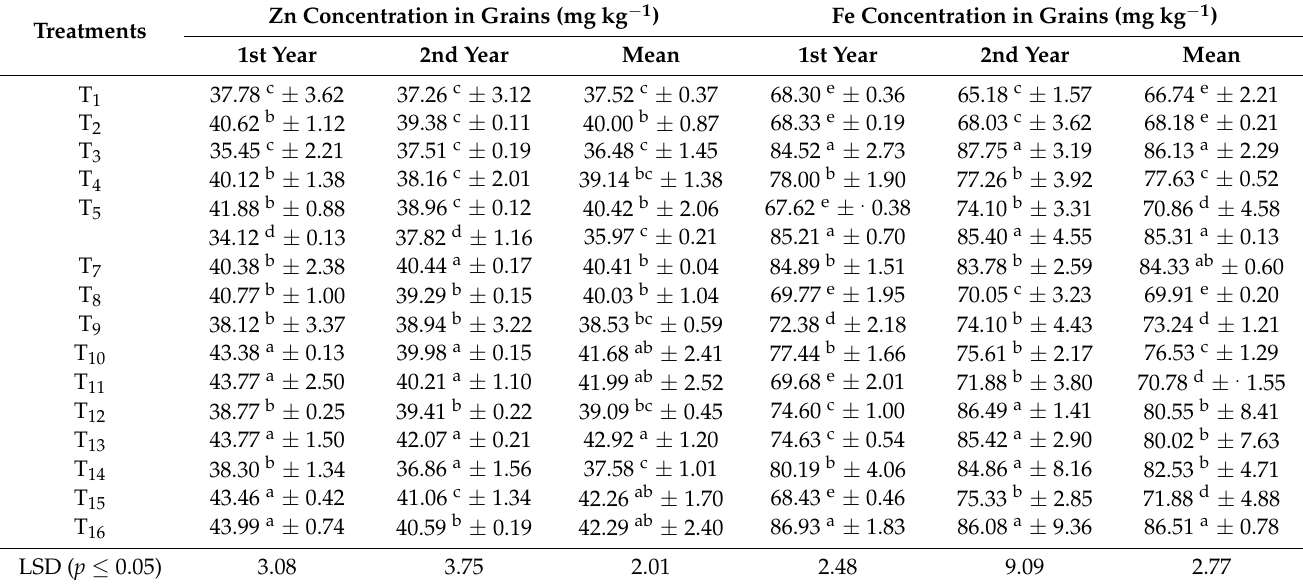
Table 3. Effect of mineral, chelated and nanoforms of Zn and Fe on the concentration of Zn and Fe in grains of chickpeas.